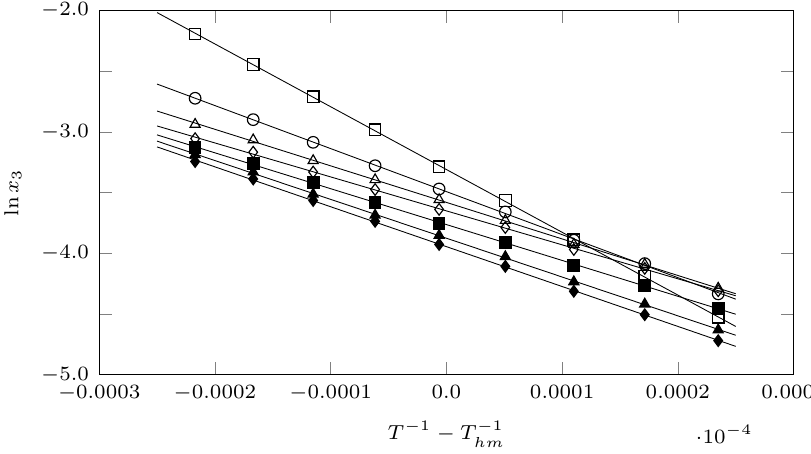
Figure 7. van ’t Hoff plot, for isoniazid (3) in (PEG 200 (1) + water (2)) cosolvent mixtures at some cosolvent mixtures, (cid:7) : w 1 = 0.0; (cid:78) : w 1 = 0.2; (cid:4) : w 1 = 0.4; ♦ : w 1 = 0.6; (cid:3) : w 1 = 1.0.